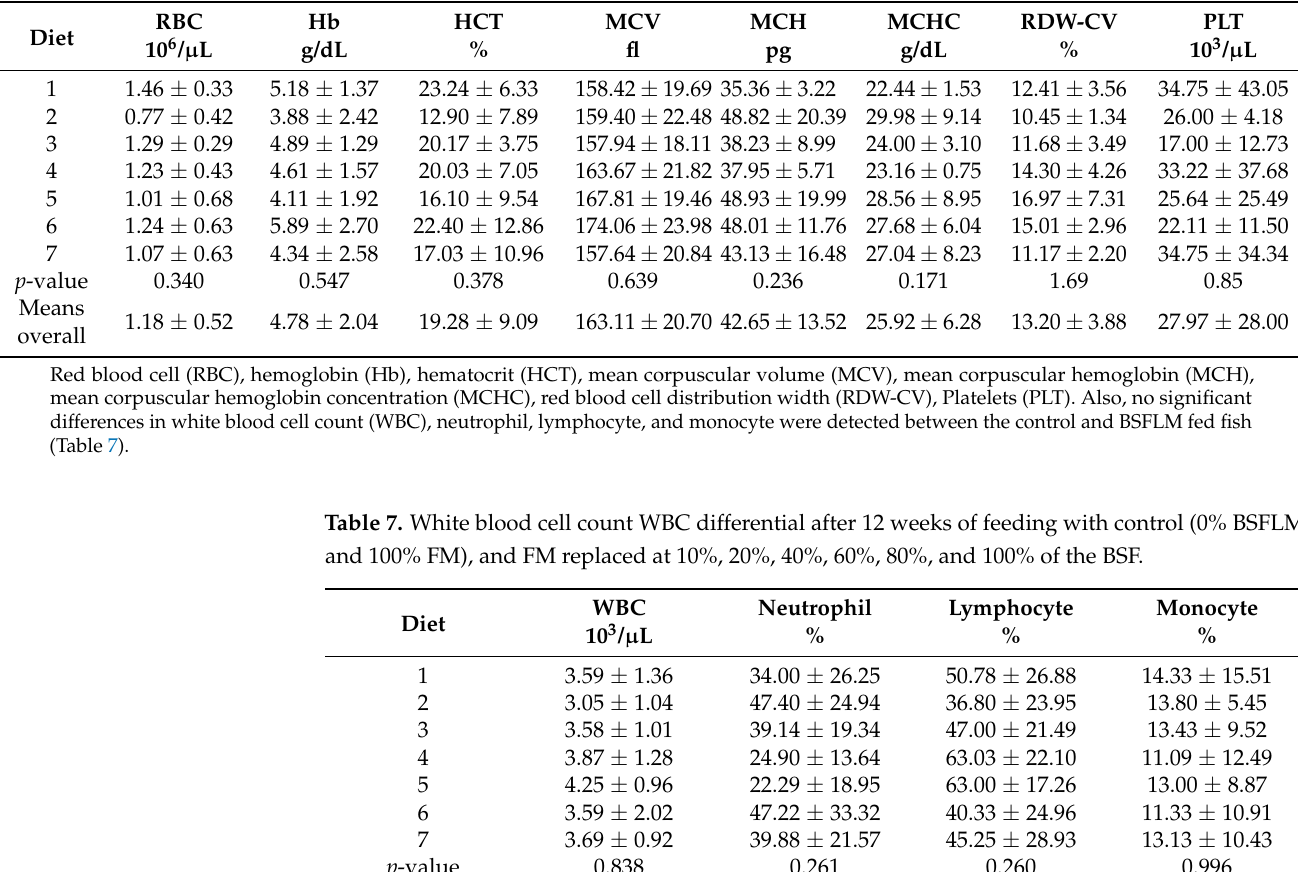
Table 8. Skin mucus lysozyme (SMLA) and skin mucus peroxidase (SMPA) after 12 weeks of feeding with control (0% BSFLM and 100% FM), and FM replaced at 10%, 20%, 40%, 60%, 80%, and 100% of the BSFLM. Skin